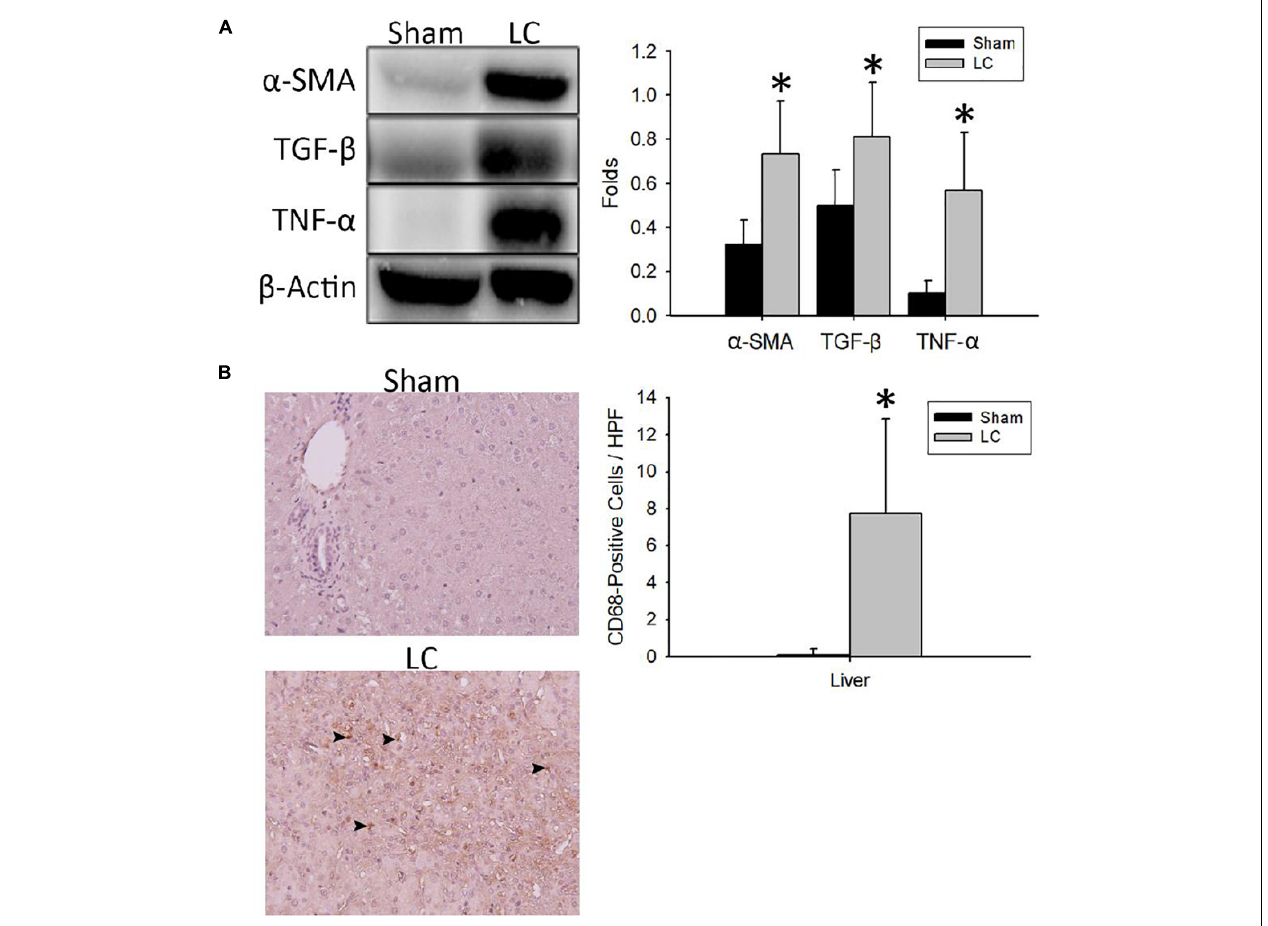
FIGURE 2 | Fibrosis and inflammation quantification of the liver parenchyma. (A) Representative Western blot images of protein expressions of fibrosis and inflammation from the liver. The α -SMA and TGF- β levels in the LC group were significantly higher than in the sham group. The TNF- α level in the LC group was significantly higher than in the sham group. (B) The left panel shows the representative images of multiple CD68-positive staining cells (denoted in black arrowheads) from the liver parenchyma in the LC group, whereas the sham group revealed negative findings. The right panel shows that the number of CD68-positive cells in the LC group was significantly increased than that in the sham group. ∗ p < 0.01, compared with the sham group. α -SMA, α -smooth muscle actin; β -actin, β -actin; CD68, anti-Cluster of Differentiation 68 antibody; HPF, high-power field; TGF- β , transforming growth factor- β ; TNF- α , tumor necrosis factor- α